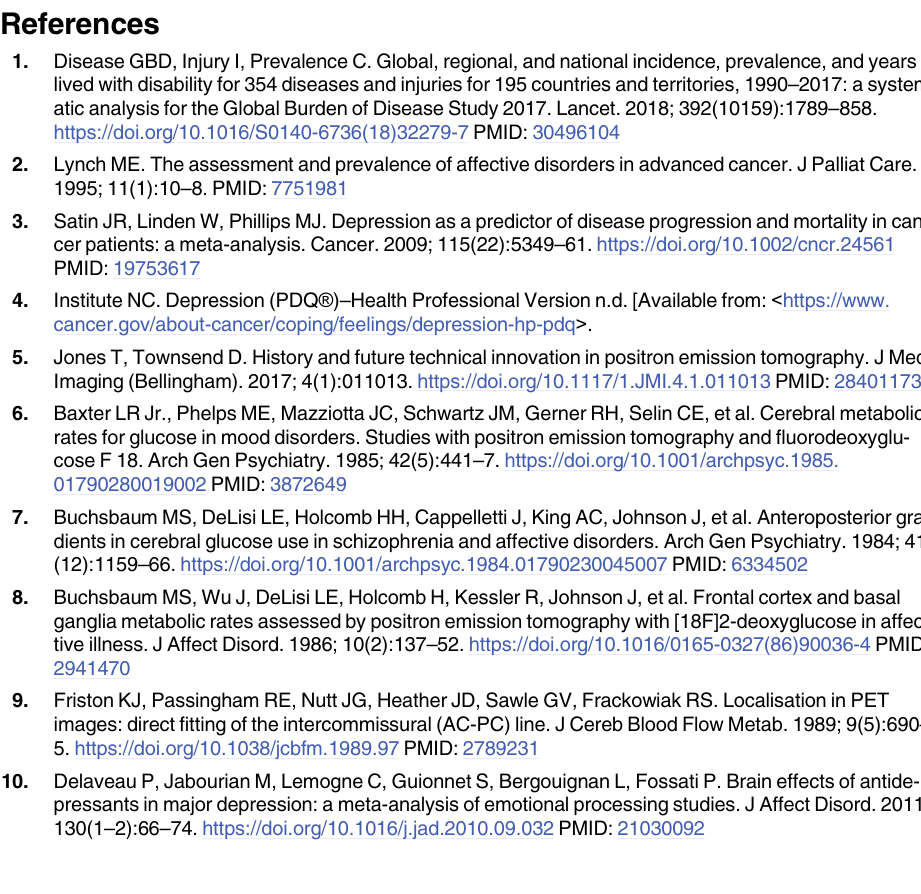
sections depicting regions of hyper-metabolic (red) and hypo-metabolic (blue) changes.